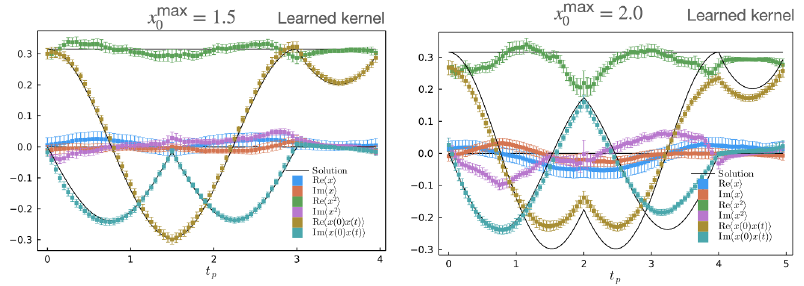
Figure 3. (left) CL dynamics of the anharmonic oscillator in the presence of our learned field- independent optimal kernel at mt max = 1 . 5. Correct convergence is restored (c.f. left panel of fig. 2) (right) Results of the CL simulations at mt max = 2, where we fail to learn a field-independent kernel to restore correct